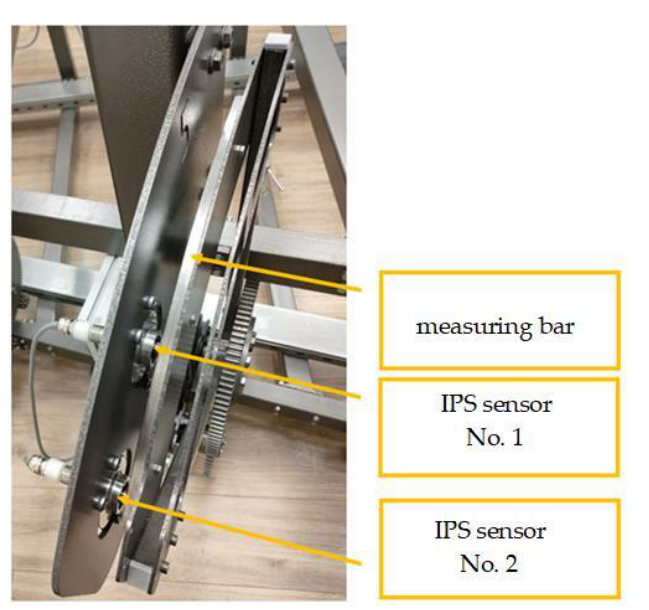
Figure 12. Location of IPS sensors and measuring bar on the slat simulator.